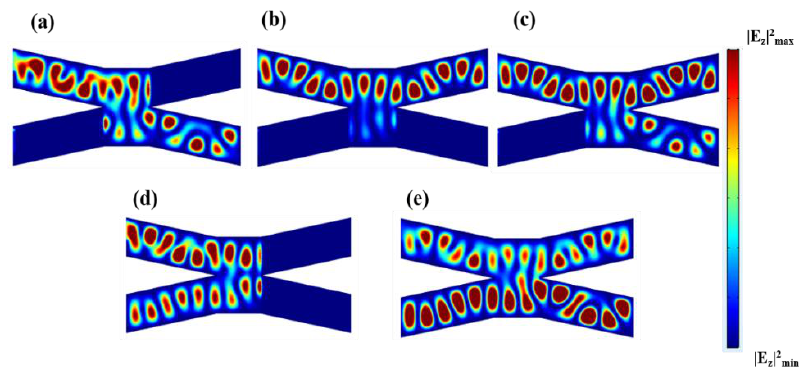
Figure 4. Distributions of | E z | 2 in the x - y plane of the X-branch switch. When the input branches “I” and “II” are ON and OFF, respectively, corresponding to input state of “10”, the output branches are in the logical states of ( a ) “01”; ( b ) “10”; and ( c ) “11”. When the input branches “I” and “II” are both ON, corresponding to input state of “11”, the output branches are in the logical states of ( d ) “00” and ( e ) “11”.